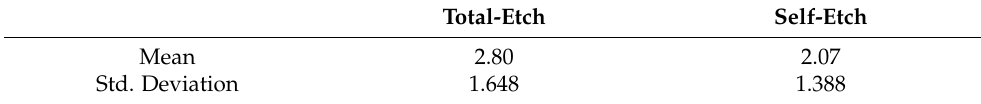
Table 4. Mann–Whitney test for comparing the micro-leakage between the groups ( p <